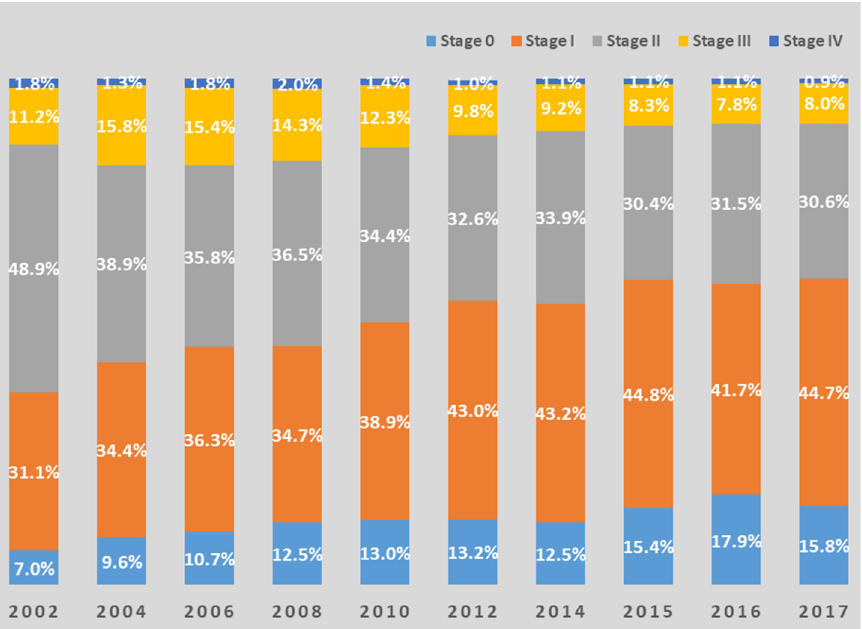
Figure 4. Changes in distribution by stage of breast cancer in Korea. Data Source: Korean Breast Cancer Society [18]. Bar charts are redrawn by authors.